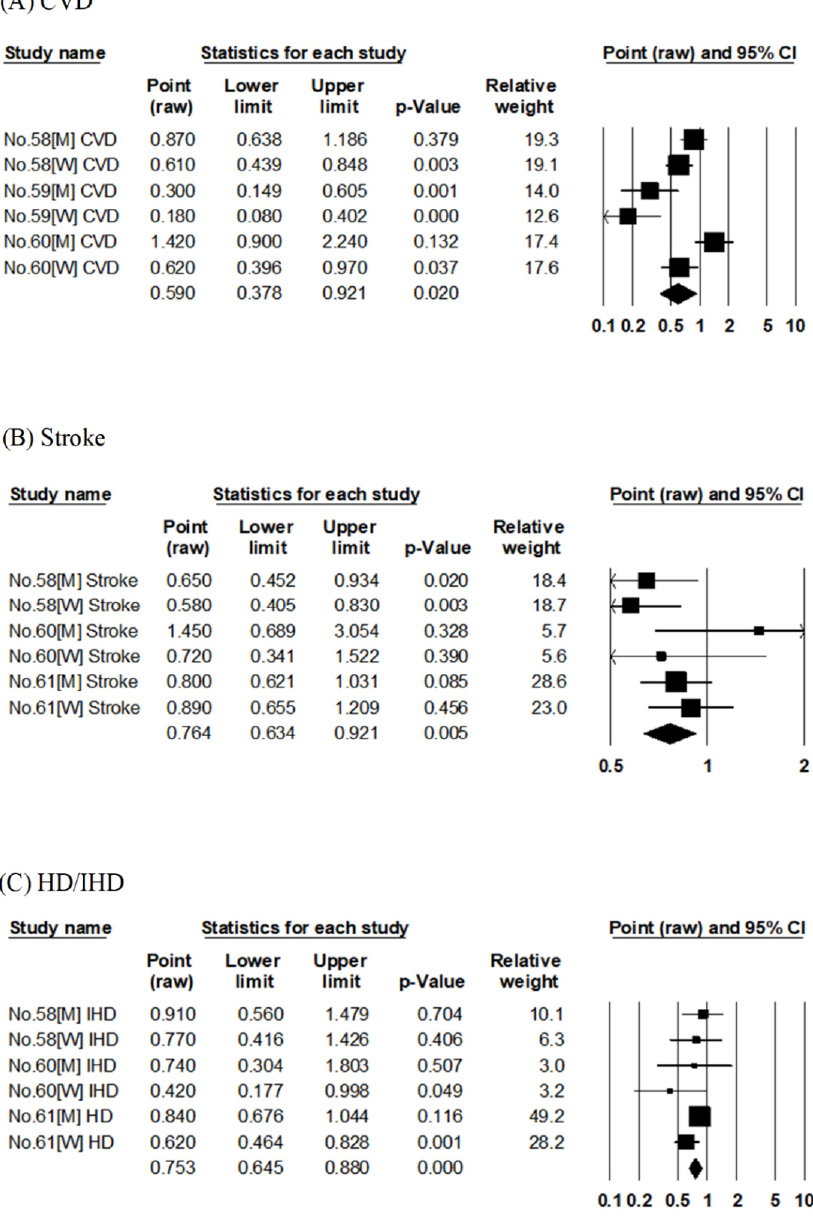
Figure 6. Meta-analysis of green tea consumption and mortality risk. ( A – C ) show the association between green tea consumption and CVD, stroke, and HD/IHD mortality risk, respectively. The area of each square is proportional to the study weight. Horizontal lines represent 95% confidence intervals. Diamonds represent pooled estimates from inverse-variance-weighted random-effects model. The number given in the study name indicates that of the cited reference [58–61]. CVD; cardiovascular disease, HD; heart disease, IHD; ischemic heart disease. Milk or Dairy Products Three publications examined the association between green tea consumption and risk of HD or IHD mortality [58,60,61] (Table S3) using the results of three cohort studies (Ohsaki Cohort 1994, JACC, and JPHC). One study evaluated the association with the risk of HD mortality [61], and two studies evaluated the association with the risk of IHD mortality [58,60]. The pooled RR for HD/IHD mortality in a comparison of the highest to lowest consumption of green tea was 0.75 (95% CI: 0.65–0.88, p < 0.001, I 2 = 1%, Egger’s test: p = 0.515), indicating a reduced risk of HD/IHD mortality in the group with the highest consumption of green tea (Table 2, Figure